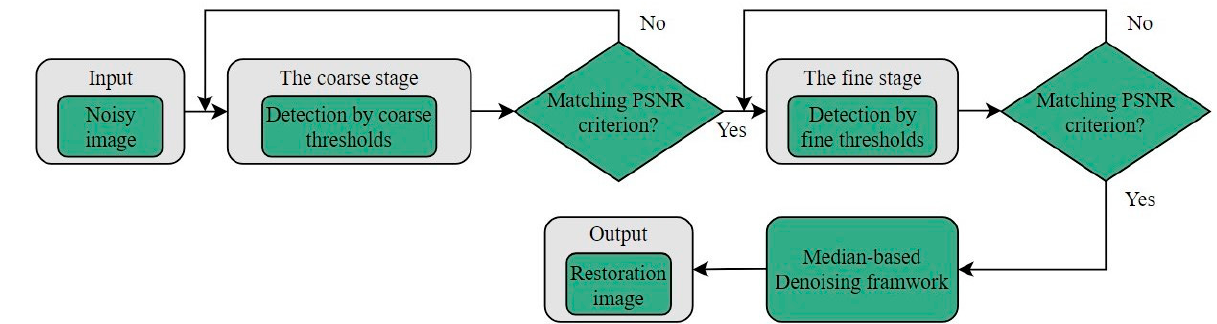
Figure 1. Structural flowchart of the ROR model.